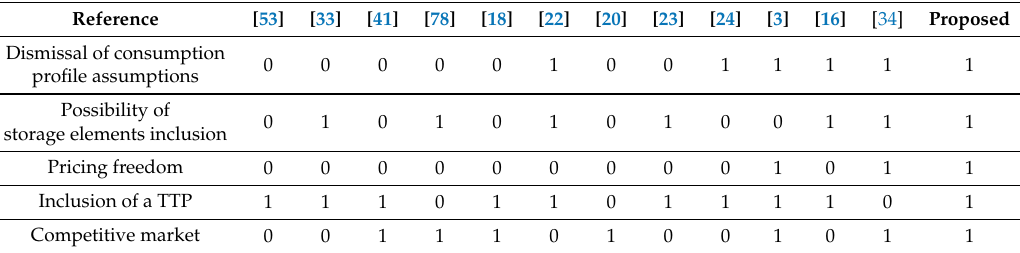
Table 3. Comparison with the state-of-the-art approaches in terms of pricing